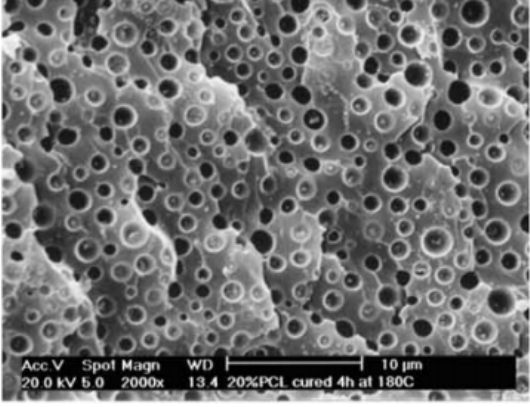
Figure 7. Phase separation in PCL/epoxy blend [49] .